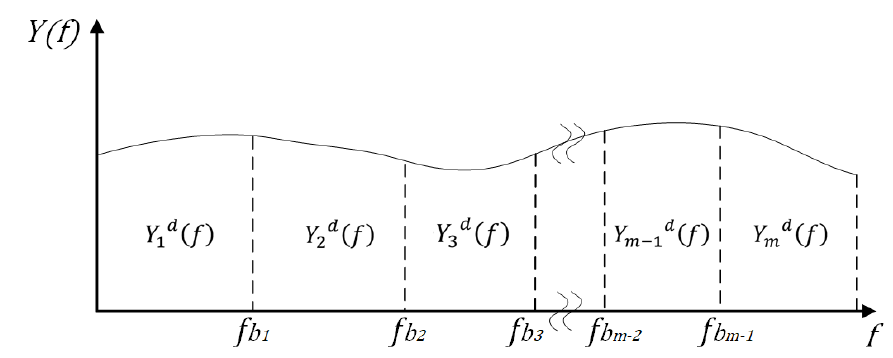
Figure 1. Spectra of the signal